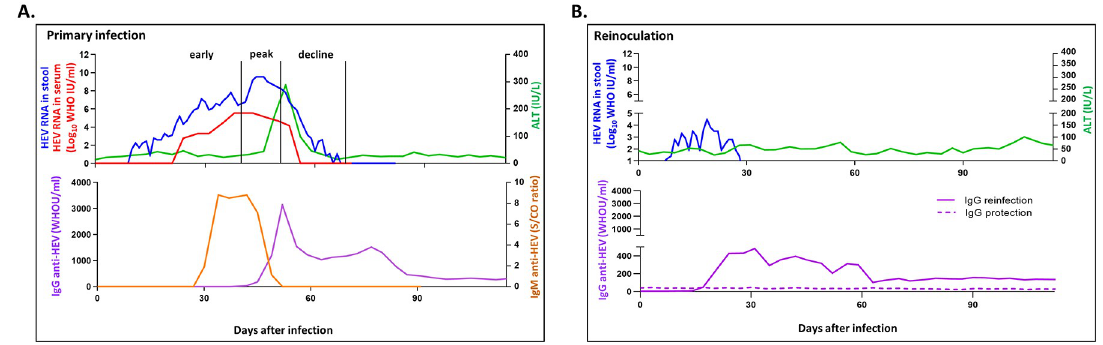
Fig 1. Schematic diagram of course of HEV gt1 and gt3 infection in rhesus macaques. The course of primary HEV gt1 and gt3 infection (A) and HEV reinfection with gt1 (B) have been described previously [21, 22]. Primary HEV genotype (gt) 1/gt3 infection and HEV reinfection were observed for 115 days after infection. Levels of HEV RNA in daily stool (blue line) and weekly serum (red line), and alanine aminotransferase (ALT) activities (green line) were shown as line graphs. Levels of IgM (brown line) and IgG (purple line) anti-HEV antibody responses were shown during primary HEV gt1/gt3